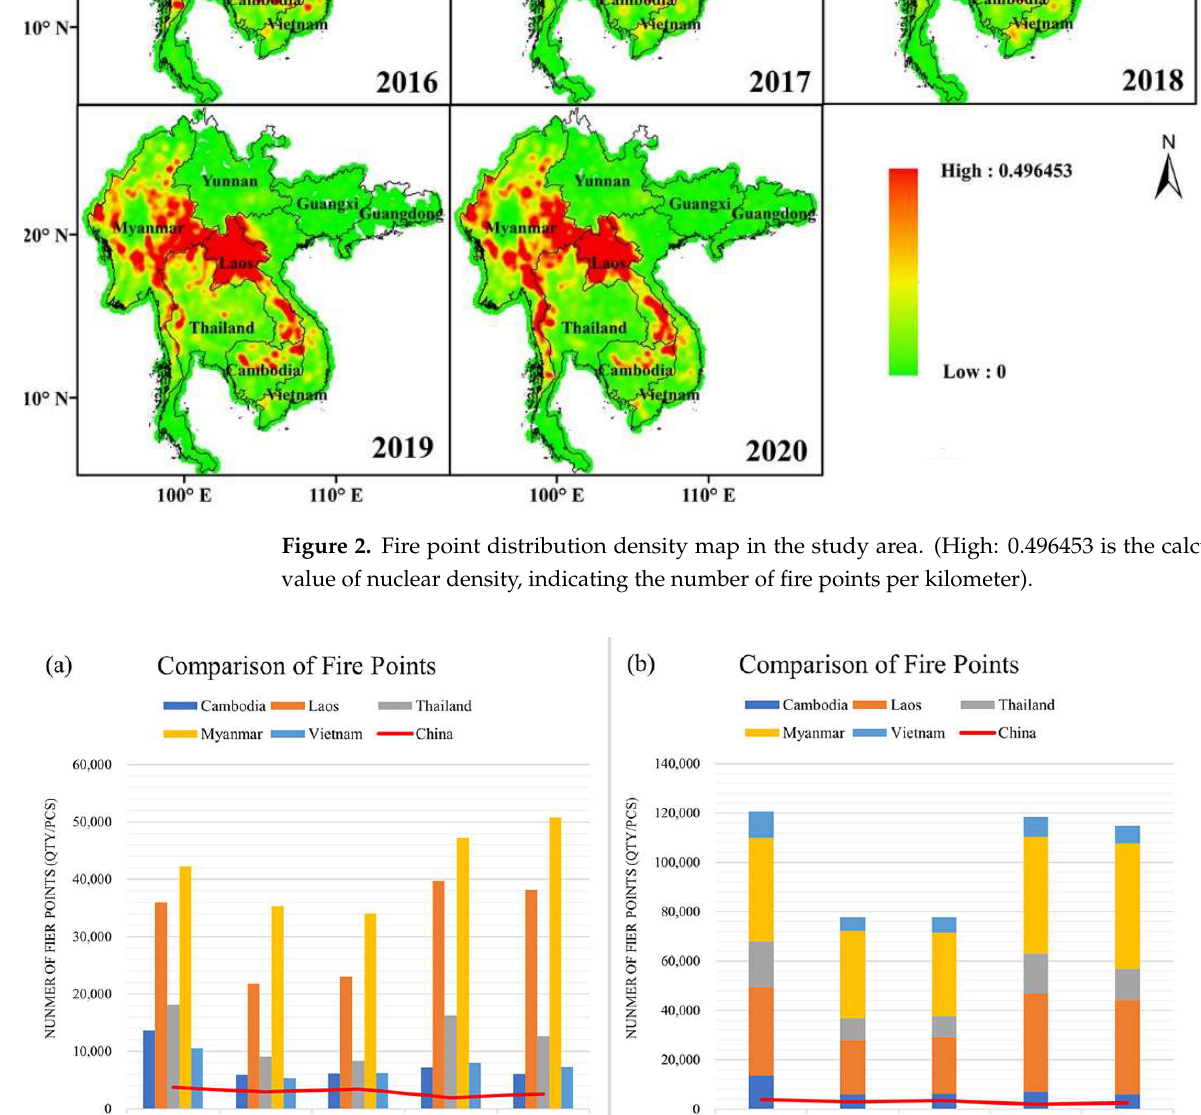
Figure 2. Fire point distribution density map in the study area. (High: 0.496453 is the calculated value of nuclear density, indicating the number of fire points per kilometer).